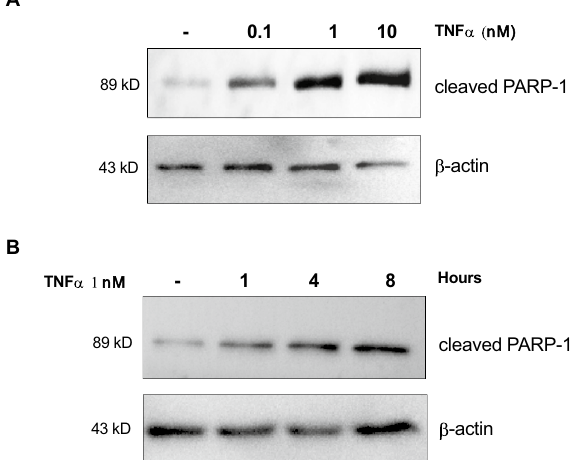
Figure 1. HCT116 cells respond to TNF-α induced apoptosis ( A ) HCT116 cells were incubated with TNF-α at the concentrations indicated for 8 h. Cells were collected and whole protein extracts were analyzed by western blot with antibodies against cleaved PARP-1 and β-actin. ( B ) HCT116 cells were incubated with TNF-α 1 nM for 1, 4 or 8 h. Cells were collected, and whole protein extracts were analyzed by western blot with antibodies against cleaved PARP-1 and